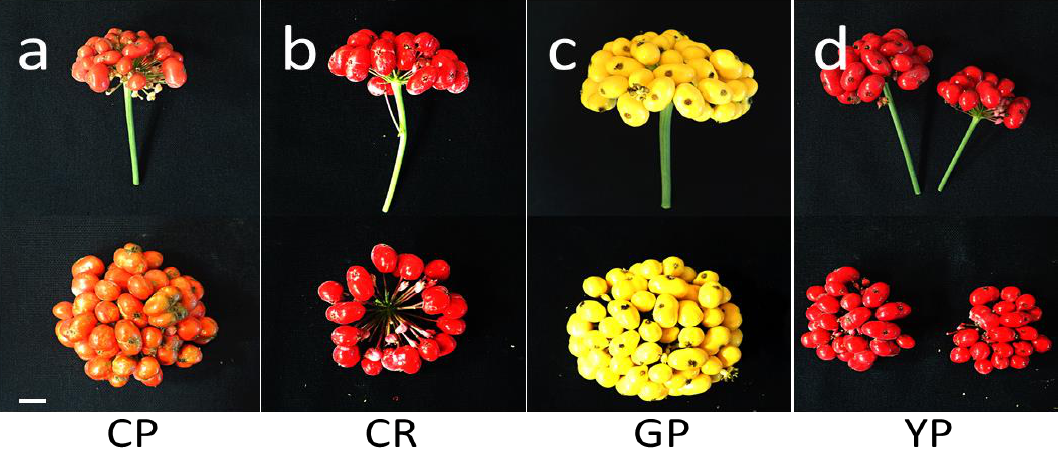
Figure 1. Fruit characteristics of P. ginseng depending on the cultivar. The fruits of the cultivar were harvested from 4-year-old ginseng. Immediately after harvesting, the characteristics of each cultivar regarding the mean number and weight of fruits and indehiscent seeds were investigated. ( a ) Chun-